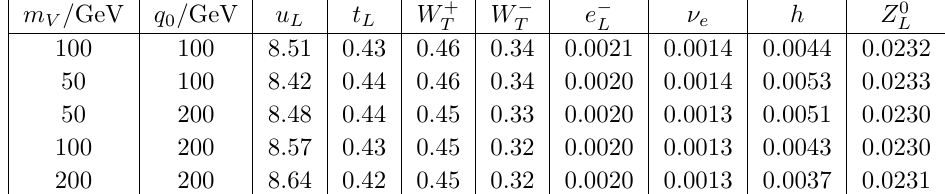
Table 2 . Momentum fractions (%) carried by various parton species at scale q = 10 TeV.